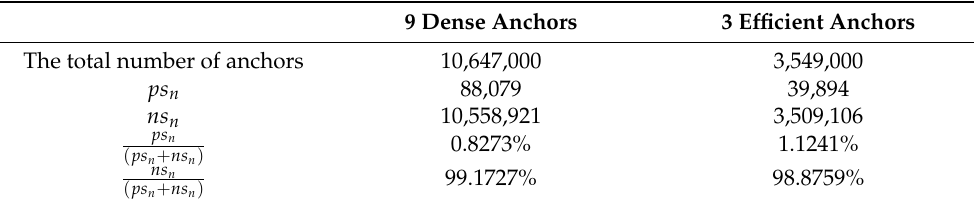
Table 1. Positive/negative sample statistics table for dense anchors and effective anchors. 9 Dense Anchors 3 Efficient